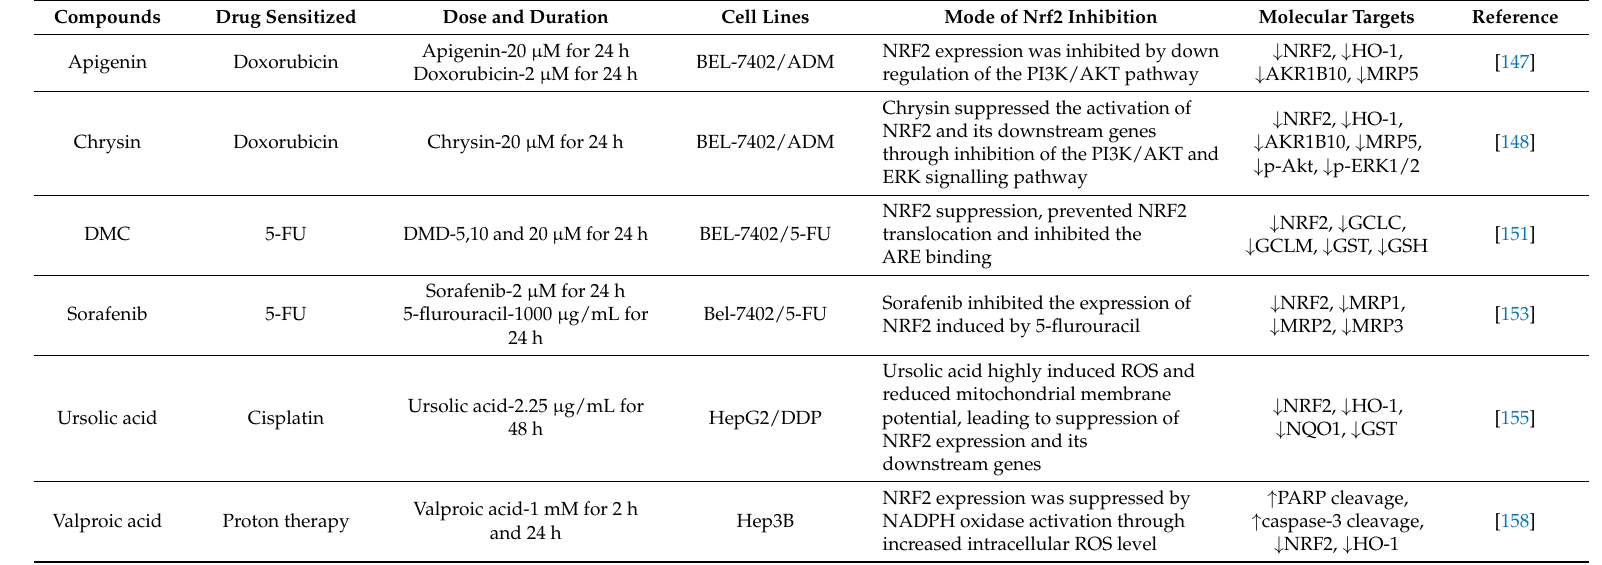
Table 2. Phytochemicals and molecules that sensitize resistant HCC against chemoresistance